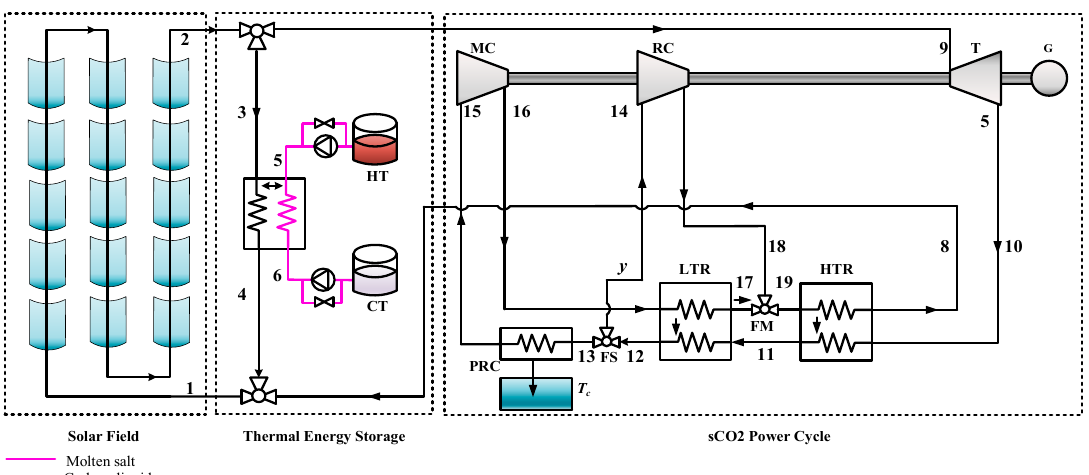
Figure 1. Schematic diagram of PTC power plant with a recompression s-CO 2 Brayton cycle.